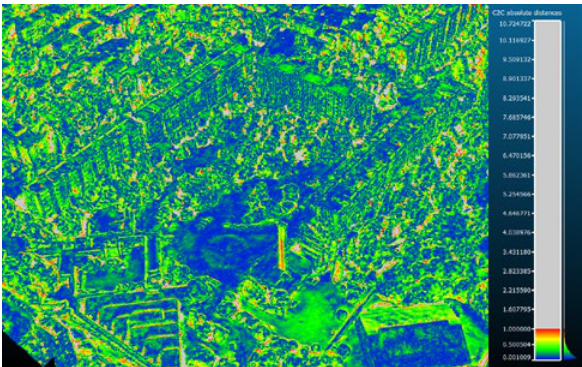
Figure 5. Result of the “cloud-to-cloud” distance computation between the dense cloud generated by ContextCapture and PhotoScan Pro.